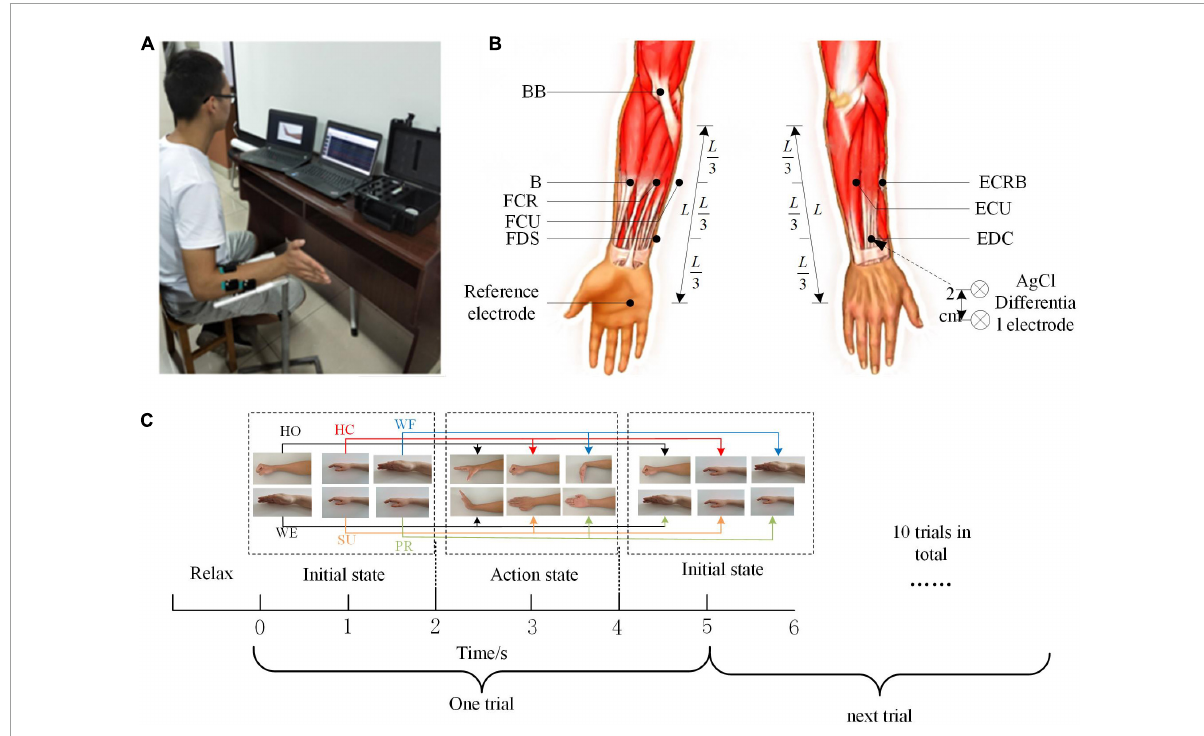
FIGURE1 Experiment program. (A) Recording of 8-channel electromyography (EMG). (B) Electrode positions for the experiment on the acquisition of EMG signals. (C) The flow of the experimental